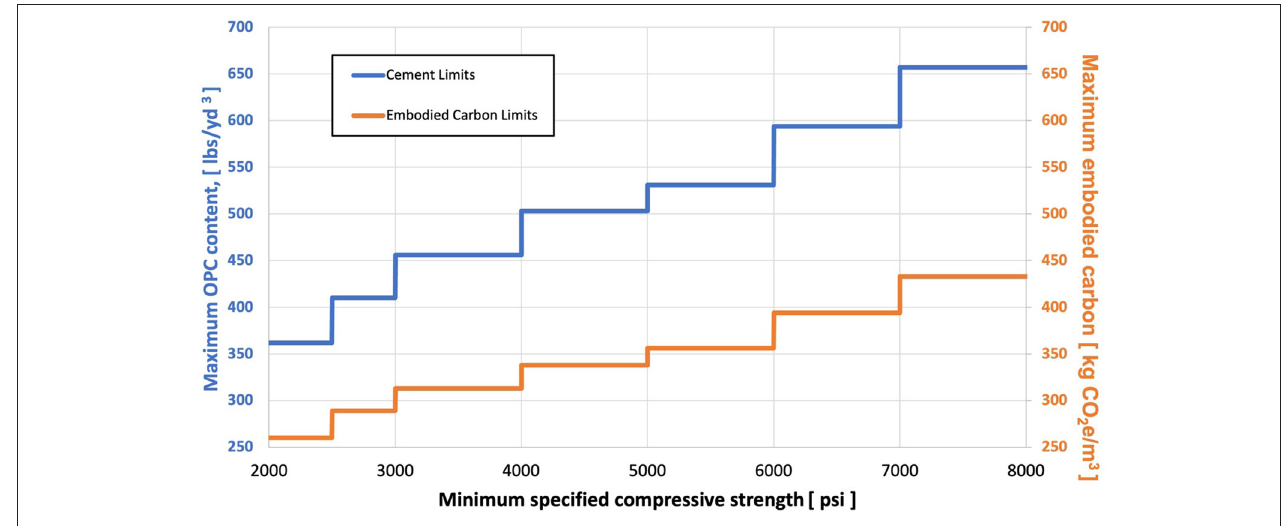
FIGURE 3 | Illustration of Marin County concrete code with both cement limits and embodied carbon limits against the minimum compressive strengths (OPC, Ordinary Portland